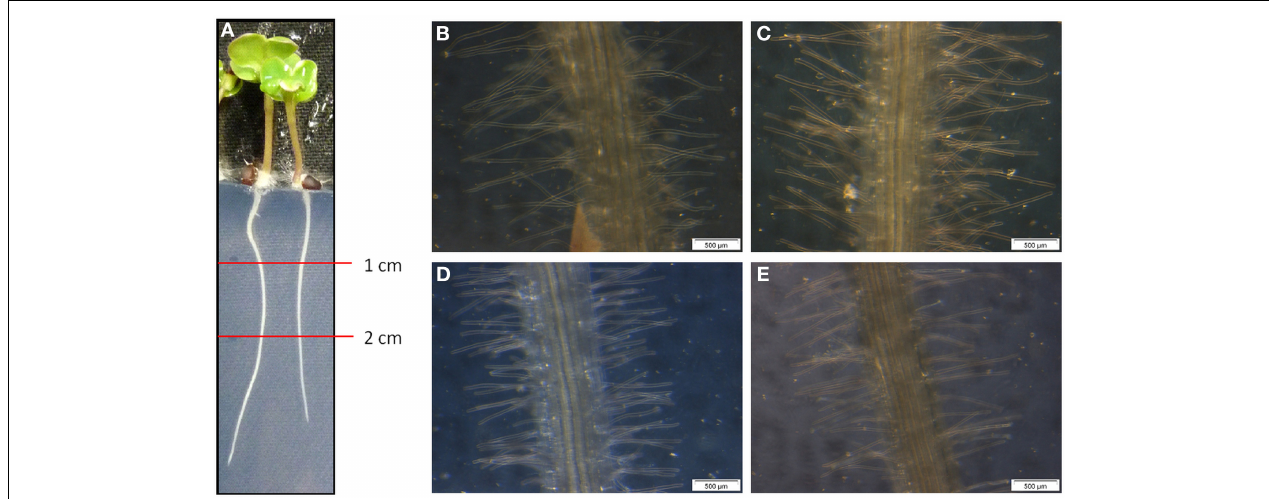
FIGURE 1 | Microscopy of root hairs. At 5-day-old seedlings of winter oilseed rape the length of the root hairs was measured using a ruler and a binocular starting one cm below the root crown. (A) 5-day-old seedling, (B) Compass, (C) Exocet, (D) Genie, and (E)